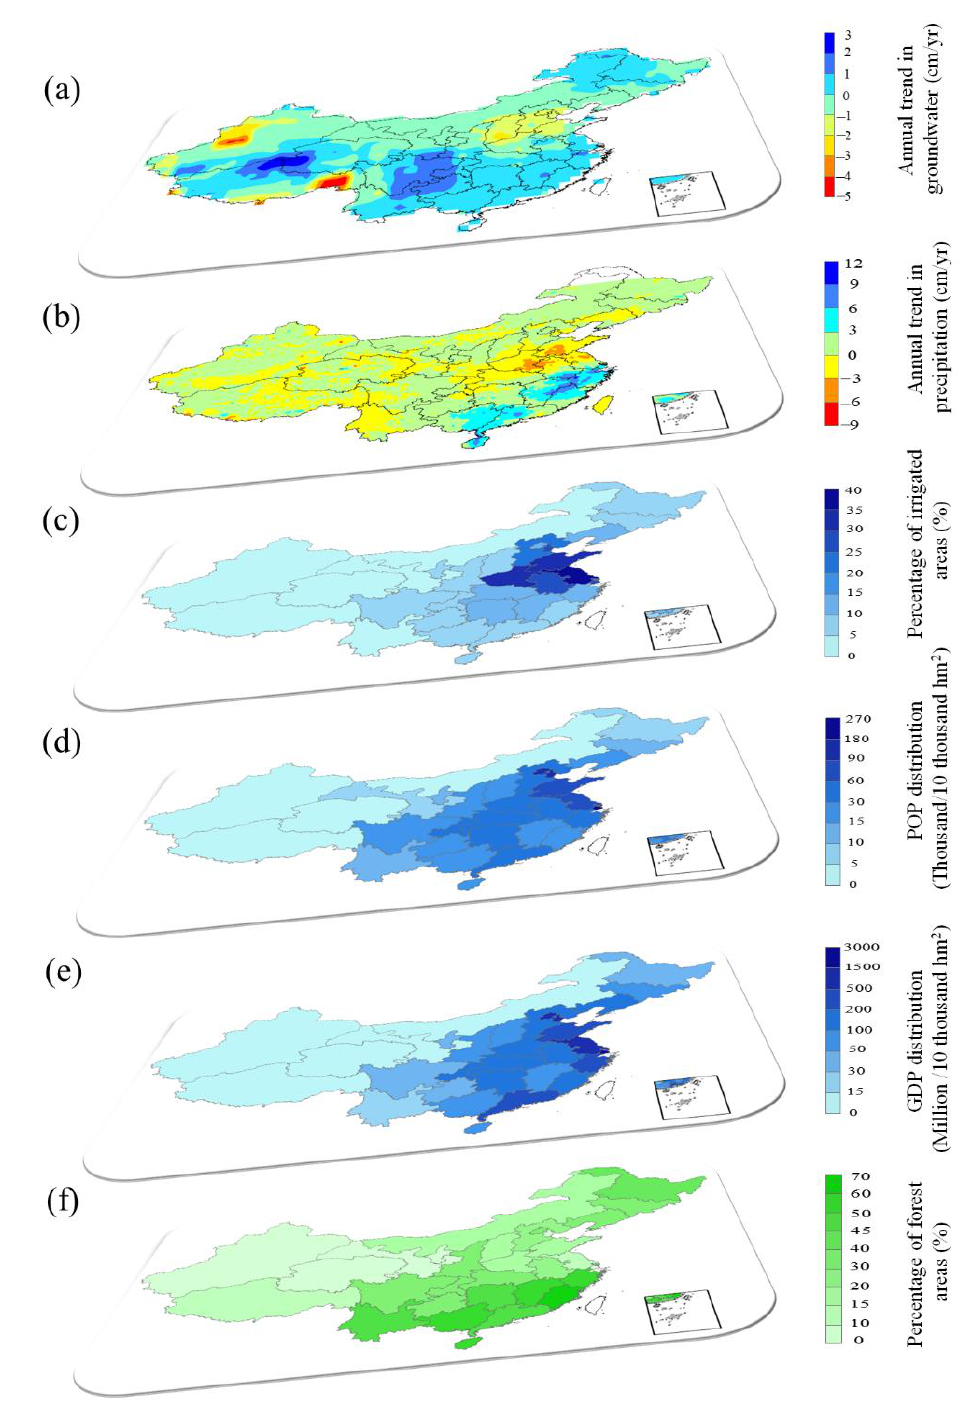
Figure 2. Trend in groundwater and main supporting data maps during 2003–2015. (Top to Bottom) ( a ) Annual trend in groundwater anomaly based on GRACE (in centimeters per year); ( b ) changes in precipitation (in centimeters per year); ( c ) percentage of irrigated areas (in percent); ( d ) GDP (in Million $ per 10 thousand hectares); ( e ) population (in thousand per 10 thousand hectares); ( f ) percentage of forest areas (in percent).